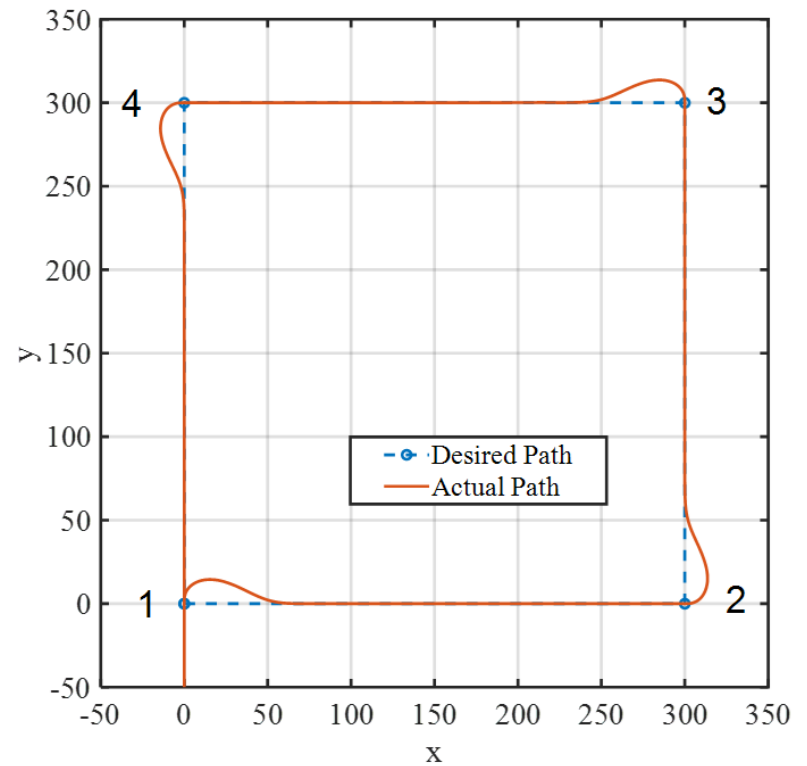
Figure 8. PPC lateral path using the non-optimized FLC.